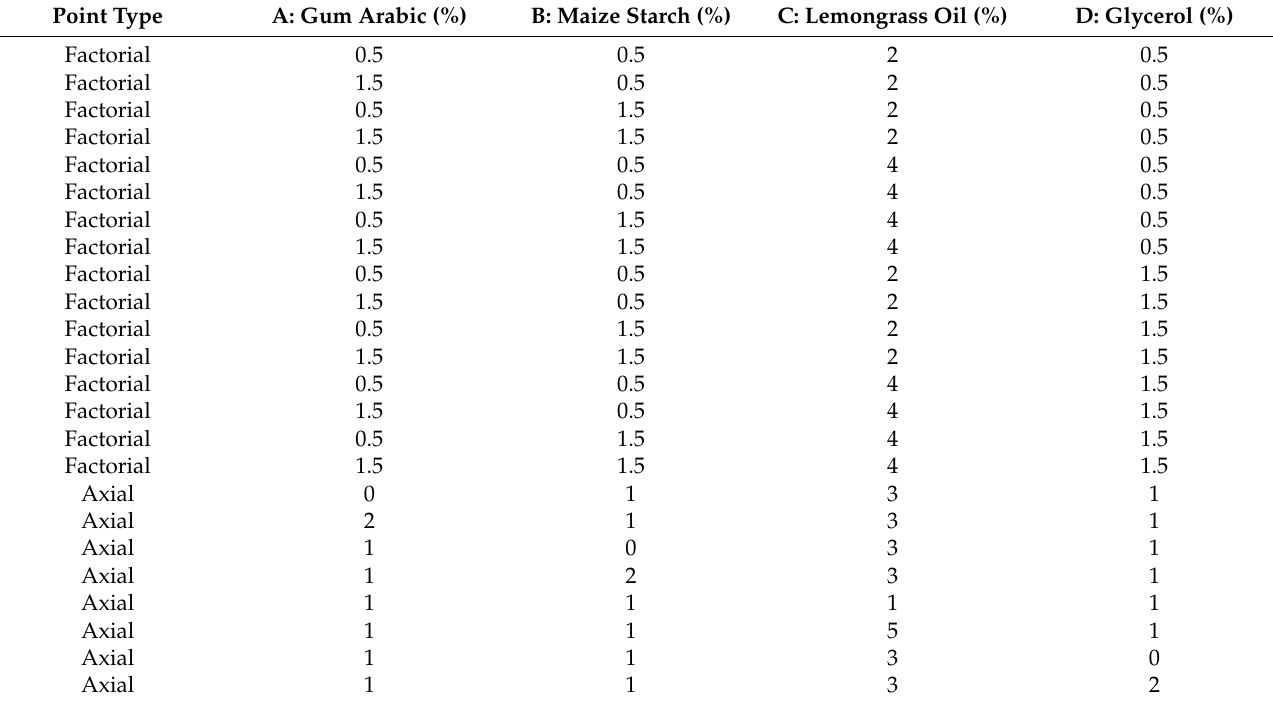
Table 1. The central composite design employed for formation of edible coating